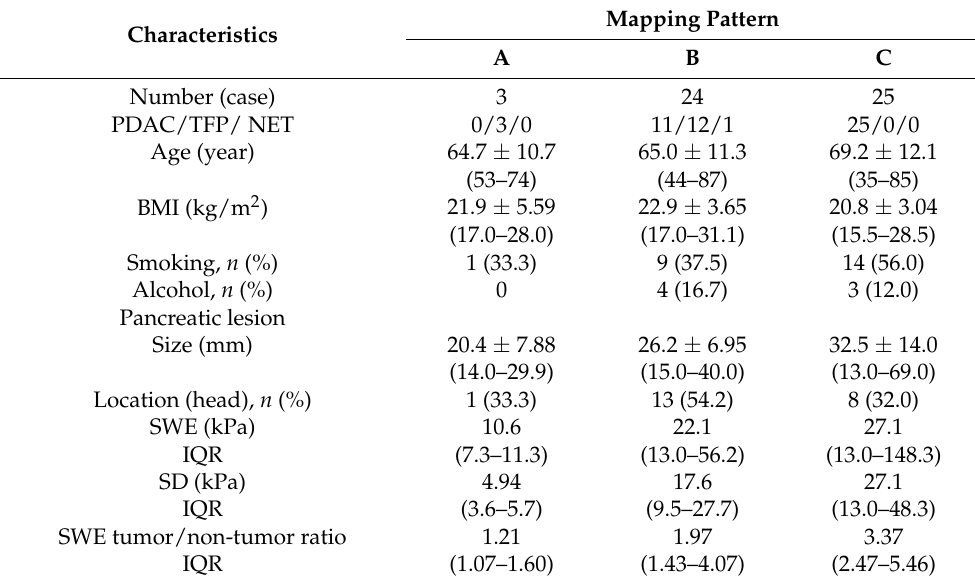
Table 2. SWE mapping patterns and patient